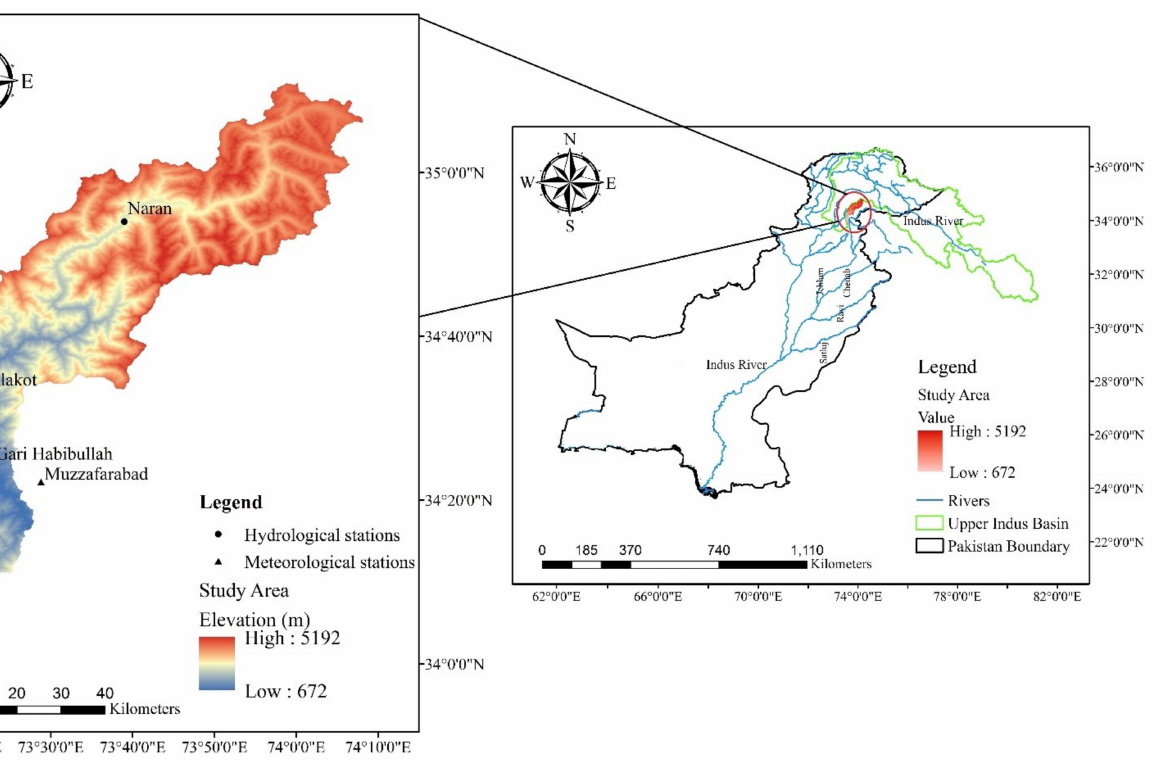
Figure 1. Geographical location of the KRB in